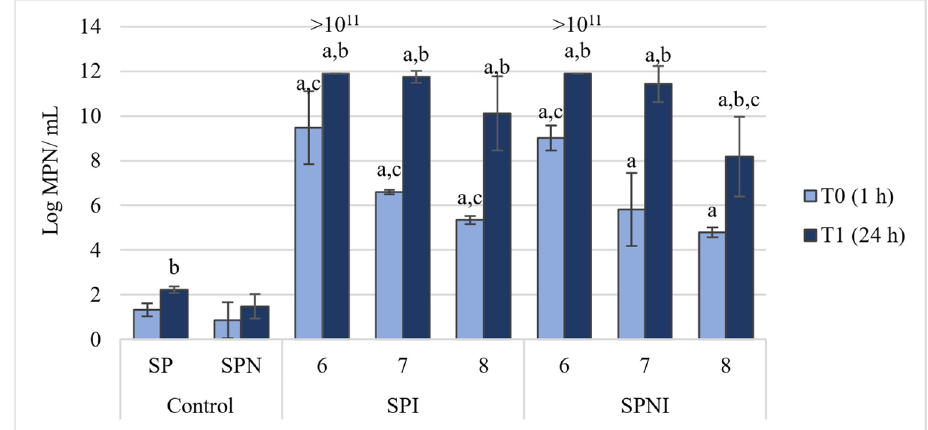
Figure 2. Abundance of hydrocarbon-degraders, evaluated by the most-probable number (MPN) method (mean value, standard deviation, n = 3), in controls SP (natural seawater + petroleum) and SPN (natural seawater + petroleum + nutrients), and in treatments SPI (natural seawater + petroleum + inoculum) and SPNI (natural seawater + petroleum + nutrients + inoculum), where a consortium of three lyophilized strains (inoculum) was added to SPI and SPNI in different concentrations: 1.7 (6), 1.7 × 10 − 1 (7), 1.7 × 10 − 2 (8) g L − 1 . a—significant differences comparing all treatments with the respective control, at the same time; b—significant differences comparing with the values at T0, in the same treatment and concentration; c—significant differences comparing with the values from other concentrations within the same treatment, at the same time.